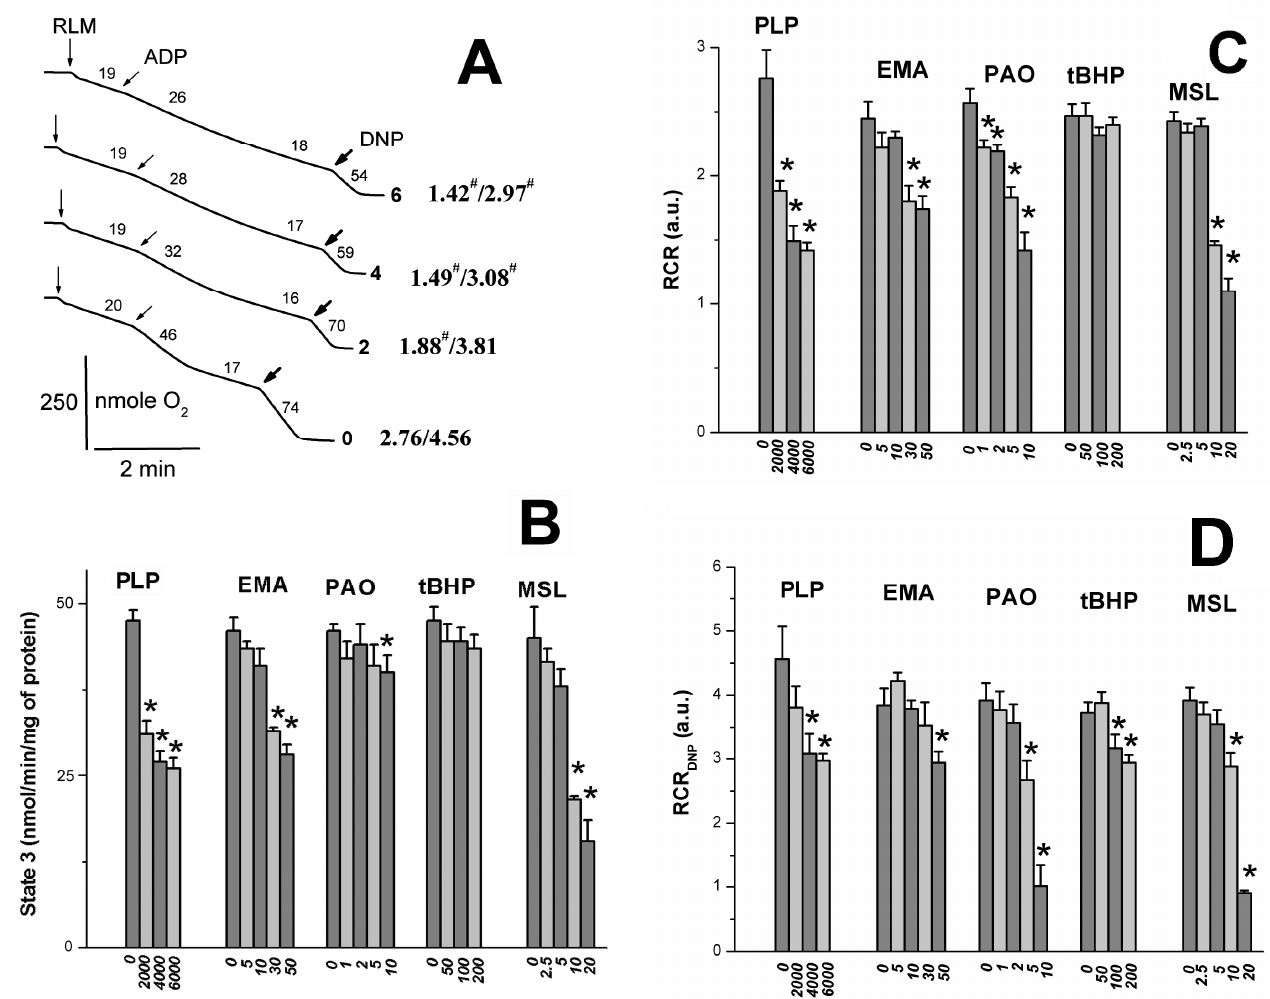
Figure 2. Effects of pyridoxal 5-phosphate and thiol reagents on oxygen consumption rates of rat liver mitochondria. Mitochondria (1.5 mg/mL of protein) were added into a medium containing 25 mM TlNO 3 , 125 mM KNO 3 , 100 mM sucrose, 5 mM Tris-NO 3 (pH 7.3), 3 mM Tris-P i , 3 mM Mg(NO 3 ) 2 , 5 mM succinate, and 2 µ M rotenone. Additions of mitochondria (RLM), 130 µ M ADP (ADP), and 30 µ M DNP (DNP) are correspondingly shown by vertical arrows, inclined arrows, and bold arrows. Oxygen consumption rates (nmole O 2 min/mg of protein) are presented as numbers placed above experimental traces. The numbers to the right of the traces ( A ) show PLP (mM) concentrations. Numbers ( A ) in bold with the slash between them to the right of the traces, respectively, show values of the RCR ADP and the RCR DNP (see the section 4). The hash to the right of the latter numbers indicates that the difference between appropriate values of the RCR ADP and the RCR DNP is statistically insignificant to the values found in experiments free of PLP. Representative traces from one of three independent experiments are presented. The ordinate ( B ) marks oxygen consumption rates (nmole O 2 min/mg of protein) in state 3. The ordinates ( C , D ) show RCR and RCR DNP values. Numbers below the abscissa (B-D) indicate the concentration (μM) of thiol reagents (PLP, EMA, MSL, PAO, and t BHP). * shows significant differences from the control (“0” under the abscissa) experiments free of thiol reagents ( p < 0.05).